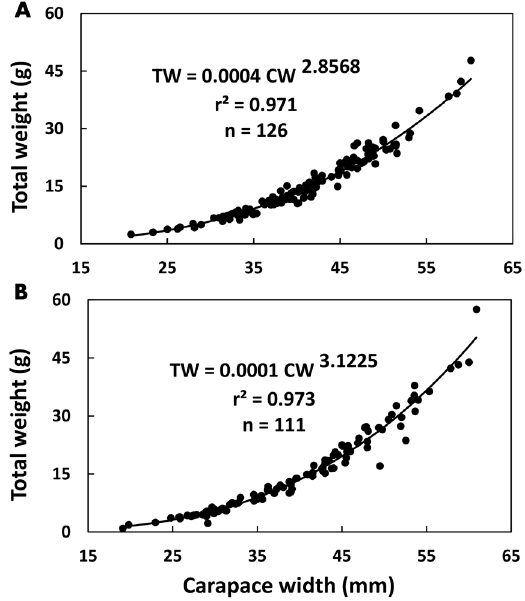
Figure 4. Relationship between total weight (TW) and carapace width (CW) for females (A) and males (B) of Hepatus pudibundus off Sergipe (northeastern Brazil) in